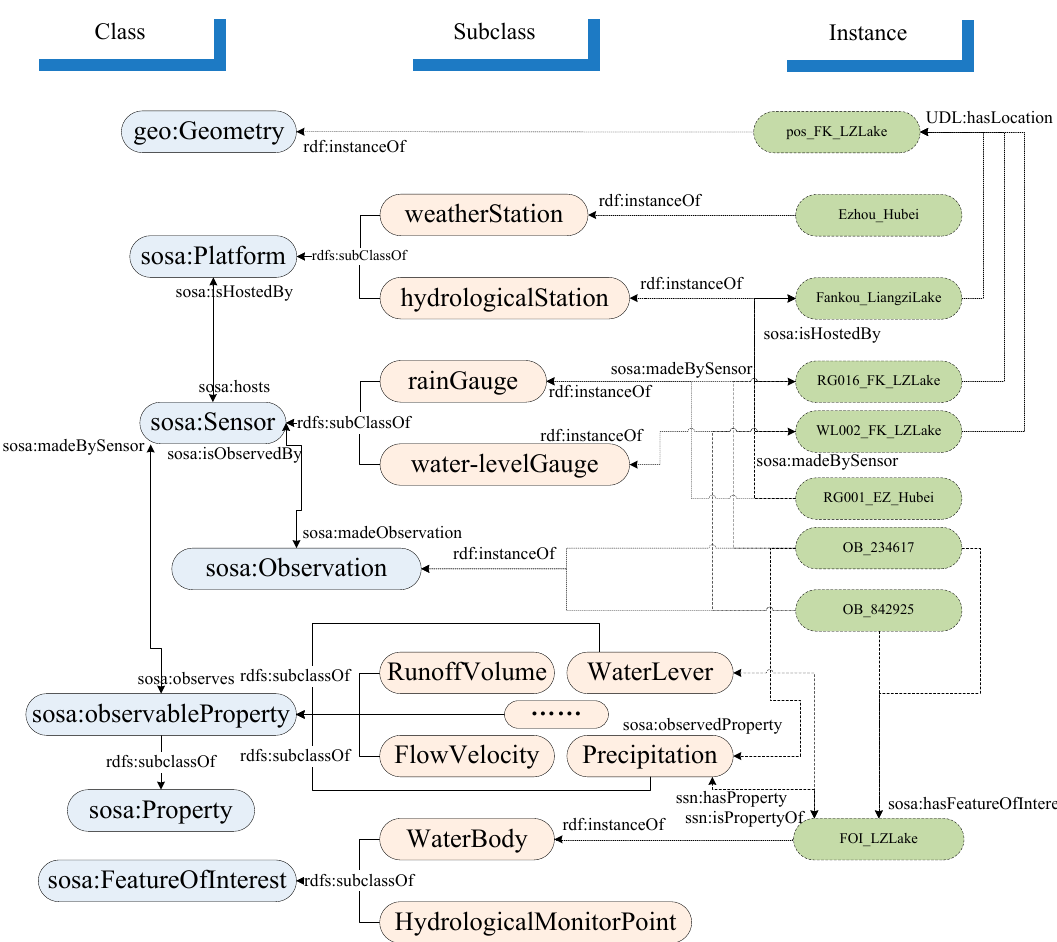
Figure 2. Main subclasses and some instances in the hydrological sensor web ontology.